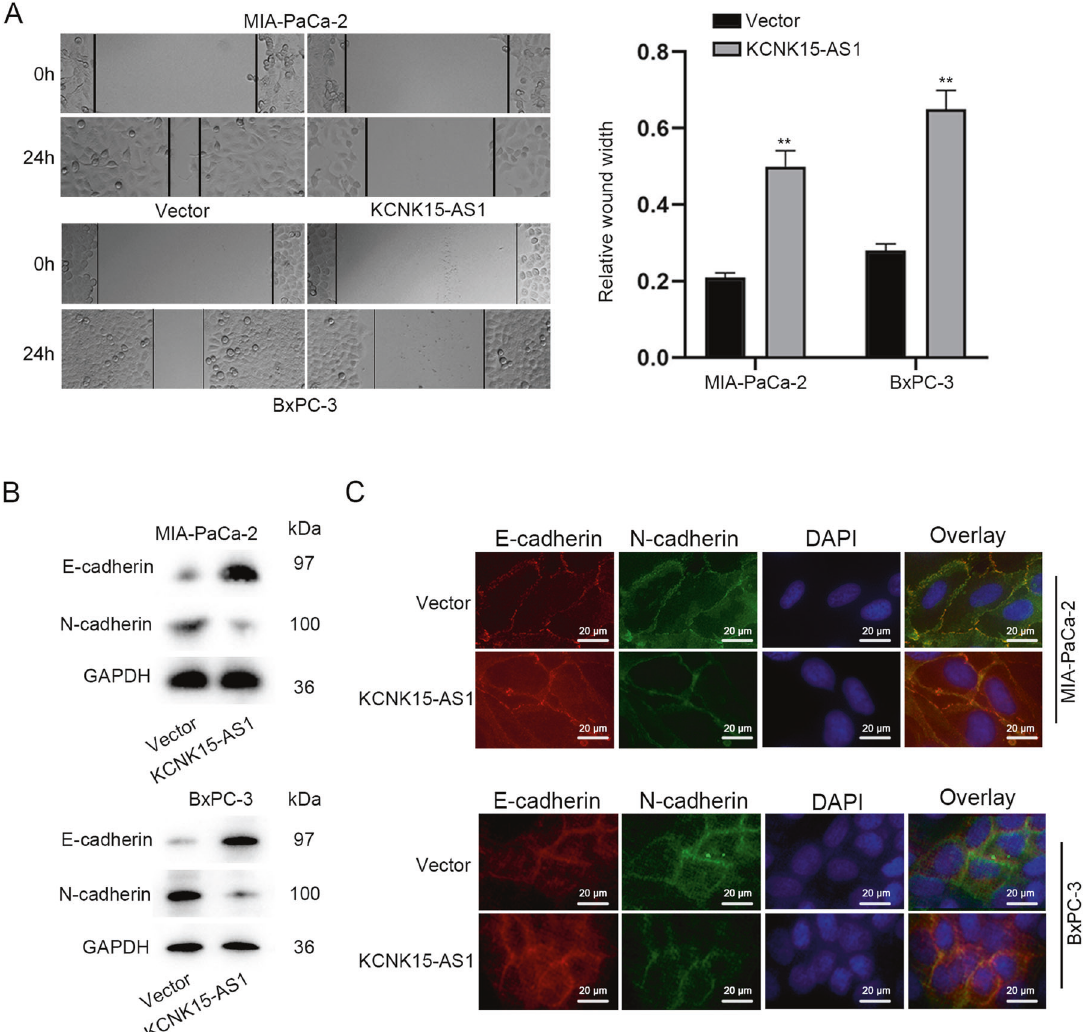
Fig. 2 KCNK15-AS1 inhibits cell migration and EMT in PC. A Cell migration was monitored by wound healing assay. B , C The in fl uence of KCNK15-AS1 on EMT markers (E-cadherin and N-cadherin) in PC cells was measured using western blot and immuno fl uorescence staining (scale bar: 20 μ m). ** P <